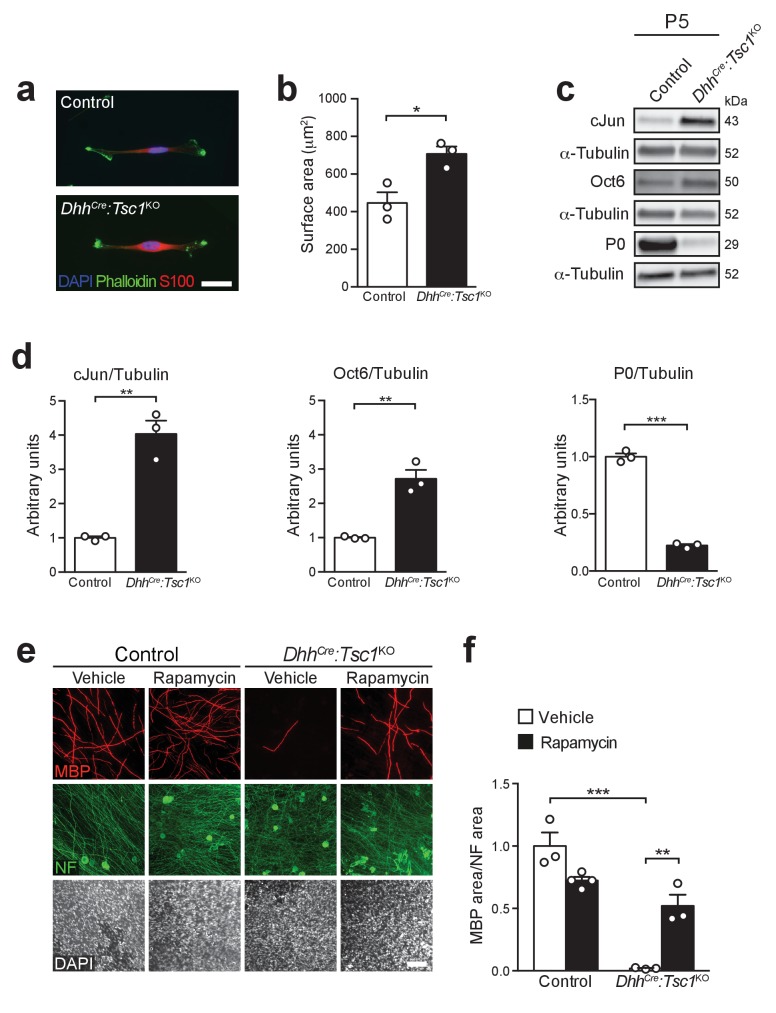
Deletion of TSC1 inhibits the onset of SC myelination by hyperactivating mTORC1.(a) Immunostaining of neonatal SCs at P2 (n = 3 mice/genotype). Scale bar: 20 μm, refers to whole panel. (b) Surface area of control and mutant cells based on the phalloidin-stained cell contour as shown in a. At least 20 cells per sample were analyzed. Bar height: mean; error bars: s.e.m. (n = 3 mice/genotype, two-tailed unpaired Student’s t-test, t(4) = 3.804, p=0.019). (c) Western blot analysis, P5 sciatic nerve lysates from control and mutant mice (n = 3 mice/genotype). (d) Quantification referring to c. Bar height: mean; error bars: s.e.m. Control average is set to 1 (n = 3 mice/genotype, including the biological replicates representatively shown in c, two-tailed unpaired Student’s t-test; cJun/Tubulin, t(4) = 7.715, p=0.0015; Oct6/Tubulin, t(4) = 6.636, p=0.0027; P0/Tubulin, t(4) = 25.04, p<0.0001). (e) Immunostaining of DRG-explant cultures from control or DhhCre:Tsc1KO embryos. Vehicle (DMSO) or rapamycin (20 nM) were added for 48 hr upon induction of myelination. Three independent experiments performed, one representative experiment shown. MBP: myelin basic protein. NF: neurofilament. Scale bar: 100 μm, refers to whole panel. (f) Quantification referring to e. Data are expressed as average ratio between the MBP-positive area and the corresponding NF-positive area. The vehicle-treated control average is set to 1. Bar height: mean; error bars: s.e.m. (n = 4 coverslips for rapamycin-treated controls, n = 3 coverslips for the other conditions, two-way ANOVA with Dunnett’s multiple comparisons test, F(1,9) = 33.43, p=0.0003; pvehicle control vs TSC1KO = 0.0001, pTSC1KO vehicle vs rapamycin = 0.0017). *p<0.05, **p<0.01, ***p<0.001.